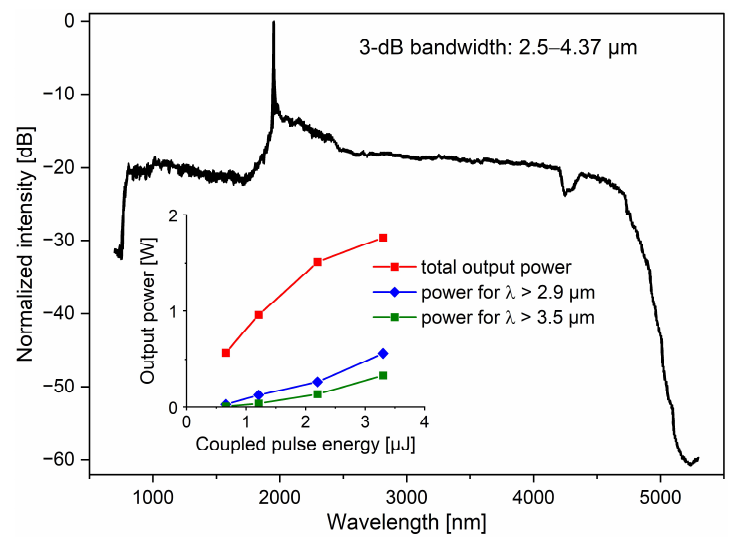
Figure 10. SC spectrum measured for the average output power of 1.76 W. Inset shows the output power in different spectrum bands as a function of the coupled pulse energy. Adapted under the terms of the Creative Commons Attribution 4.0 License [114]. Copyright 2018, Optica Publishing Group.